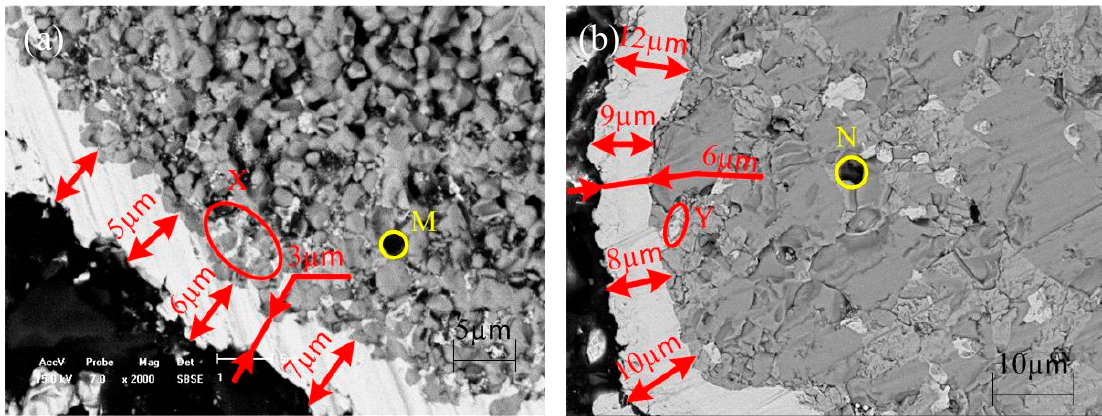
Figure 4. SEM images of Ni-P coatings on NiFe 2 O 4 electroless plated ( a ) with sensitization-activation and ( b ) Pd-free pretreatment.